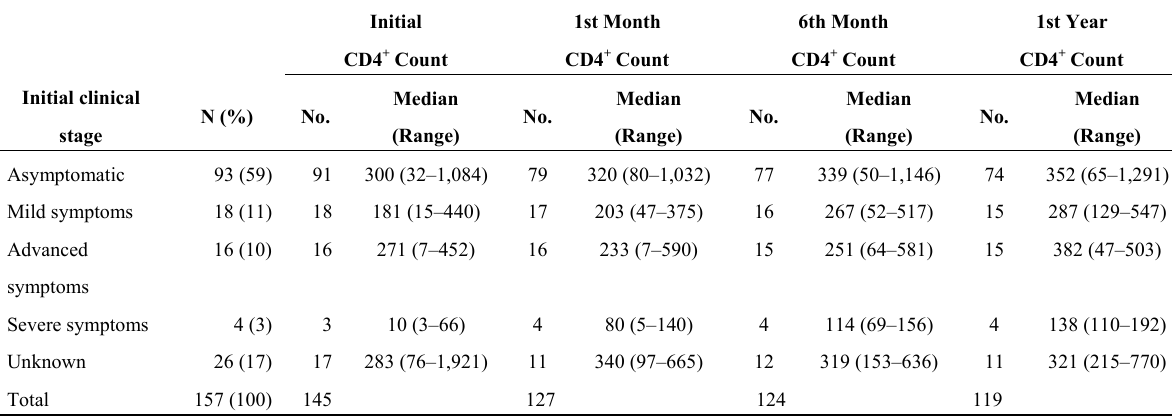
Table 2. Estimated World Health Organization Clinical Stage of HIV/AIDS and